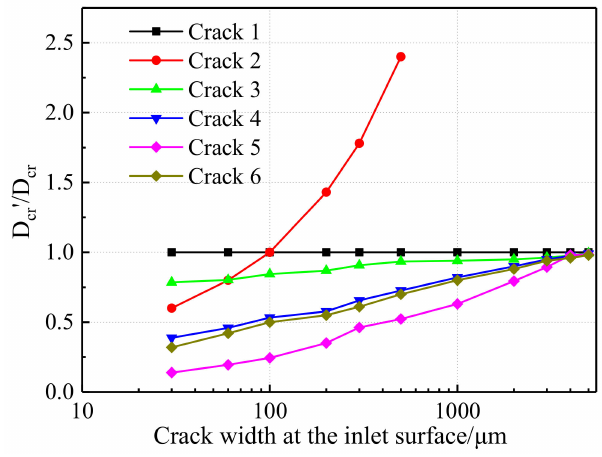
Figure 4. The effect of crack width on the apparent chloride diffusivity of concrete